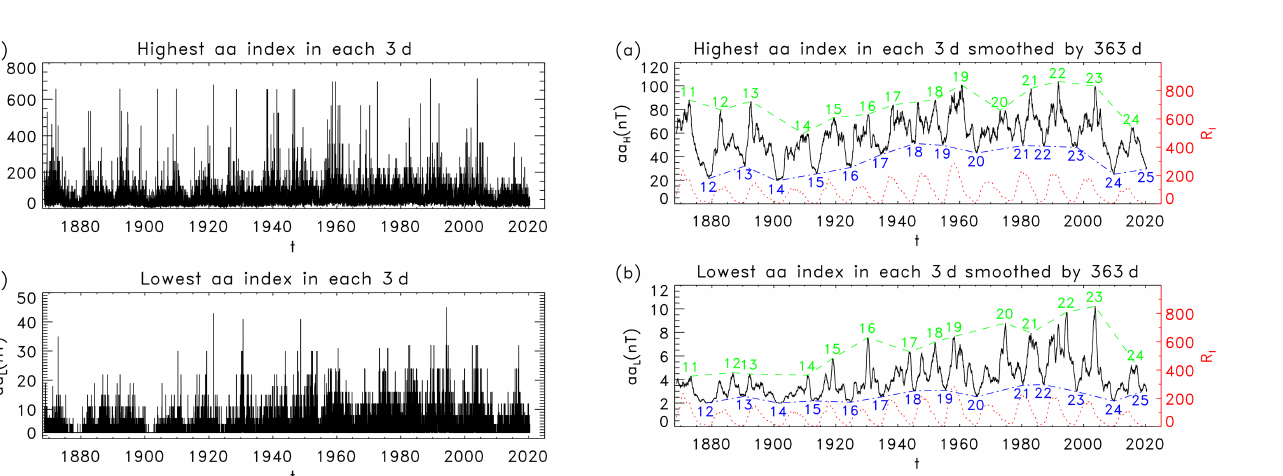
Figure 1. (a) The highest ( aa H ) and (b) lowest ( aa L ) 3-hourly aa index in each 3d.